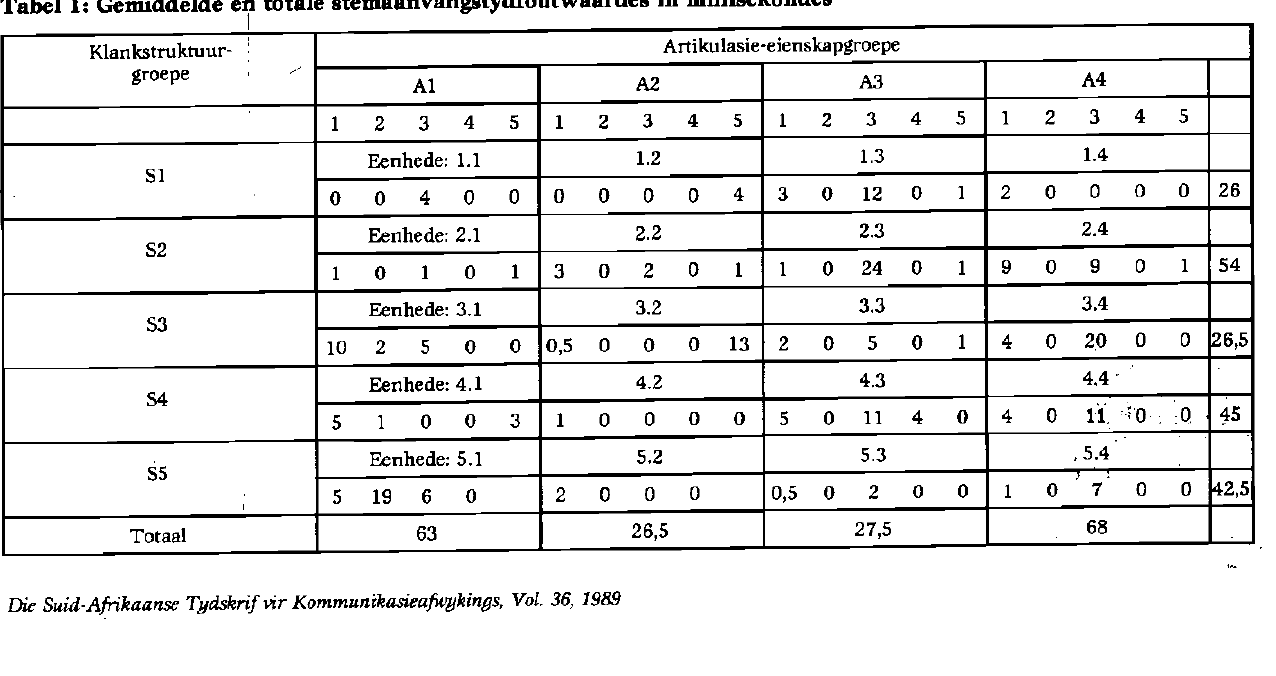
Tabel 1: Gemiddelde en totale stemaanvangstydfoutwaardee in millisekondes Klankstruktuur-